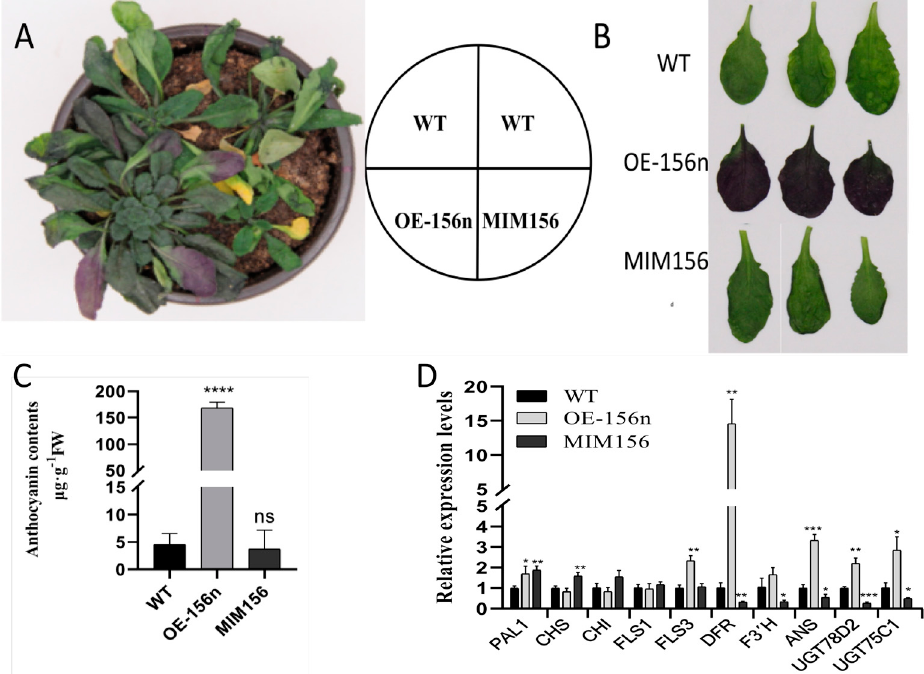
Figure 5. Mdmir156n is involved in the drought-induced accumulation of flavonoids and anthocyanins: ( A ) Phenotypes of WT, OE-156n, and MIM156 transgenic A. thaliana lines under drought treatment. ( B ) Anthocyanin accumulation on the back of leaves deprived of water for 10 days. ( C ) Anthocyanin contents in wild-type, OE-156n, and MIM156 lines under drought treatment. ( D ) Expression analysis of the flavonoid biosynthetic pathway genes in WT, OE-156n, and MIM156 lines. Values are means SD of three independent biological replicates. Asterisks indicate statistically significant differences (* p < 0.05, ** p < 0.01, *** p < 0.001, and **** p < 0.0001, ns: no significant difference, one-way ANOVA).